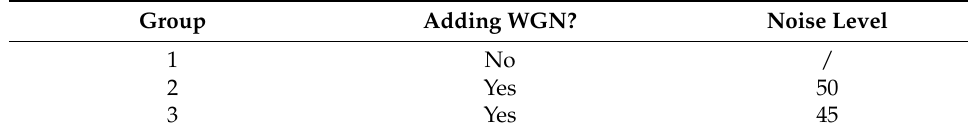
Table 2. Simulation configurations.